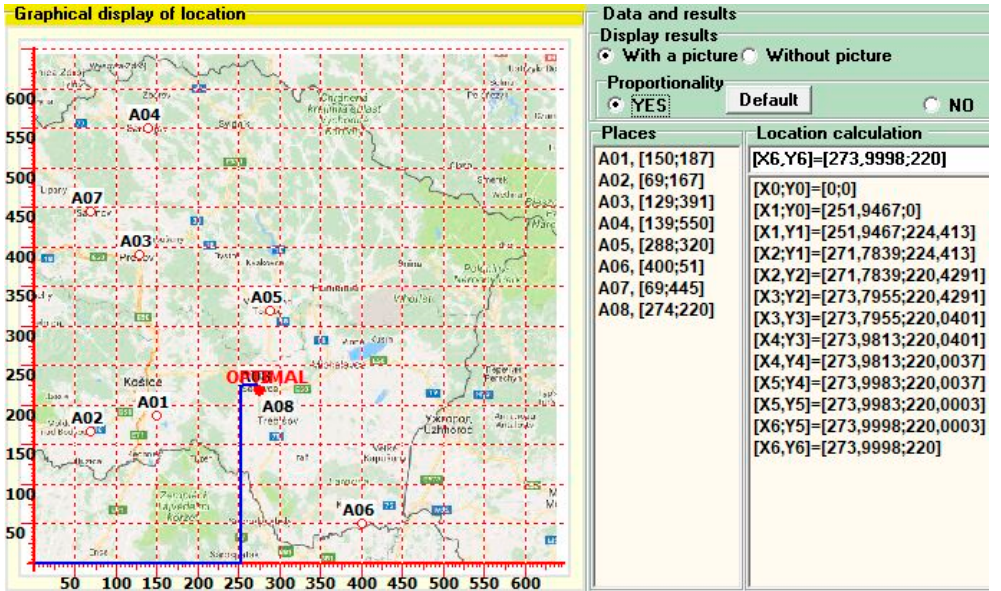
Figure 16. Graphical display of the solution of the case study location problem, obtained using the computer-aided location expert system.